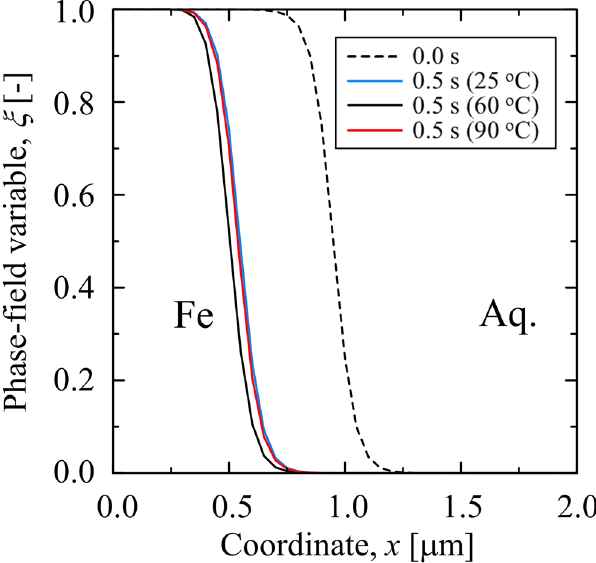
Figure 4. Profiles of the phase field variable indicating the position of the iron electrode surface before and after the general corrosion for 0.5 s at different temperatures and the pH of 2.5 (case #1, #2 and